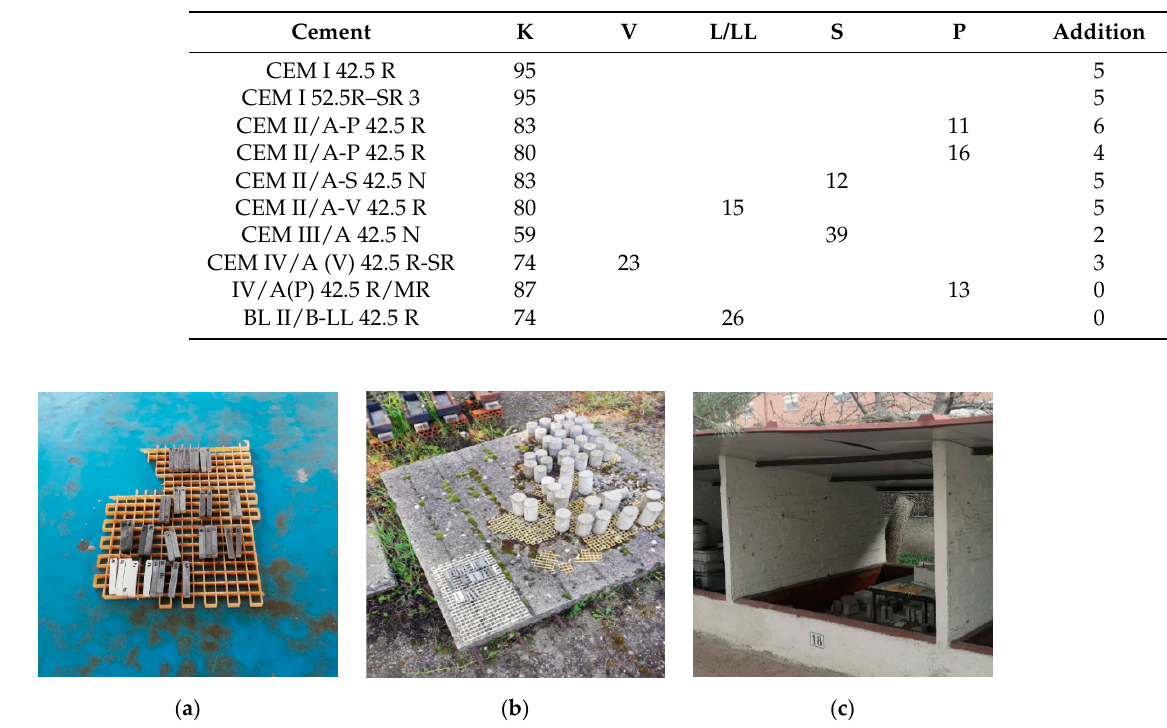
Table 2. Composition (%) of the cements used in the tests.